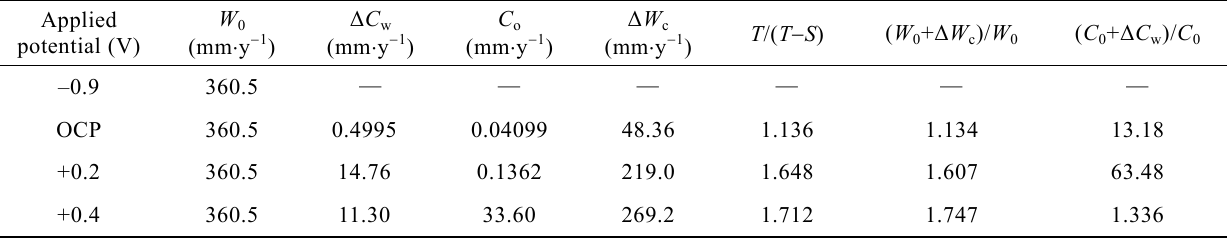
Table 5 Summary of various material loss components for AISI 2205 duplex stainless steel at different applied potentials after sliding under 80 N load and 80 rpm